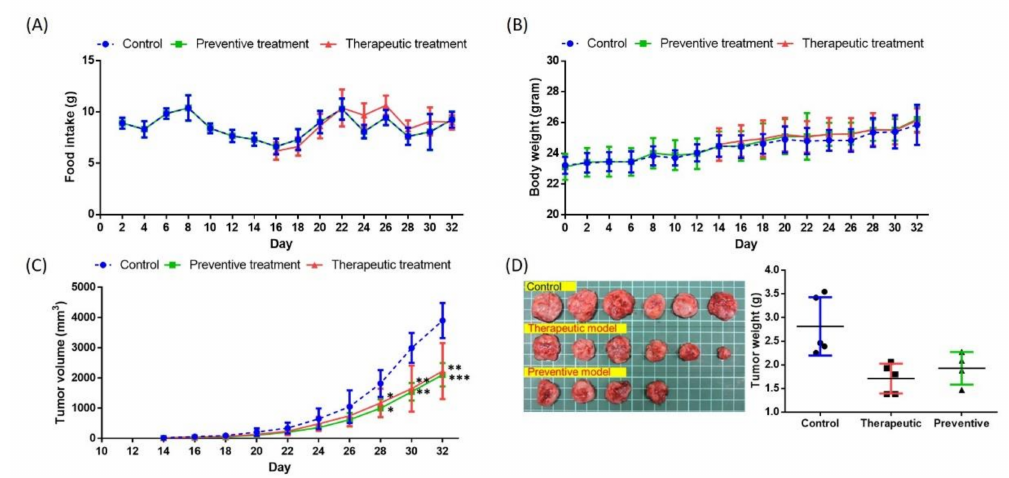
Figure 3. Effects of GF-EPS on LLC1-bearing mice. ( A ) Food intake, ( B ) body weight, and ( C ) tumor volume were measured every other day. ( D ) Images and weights of the tumors in the three groups. Data are expressed as the mean ± SD. Differences compared with the control groups with statistical significance at p < 0.05 (*), p < 0.01 (**), and p < 0.001 (***).